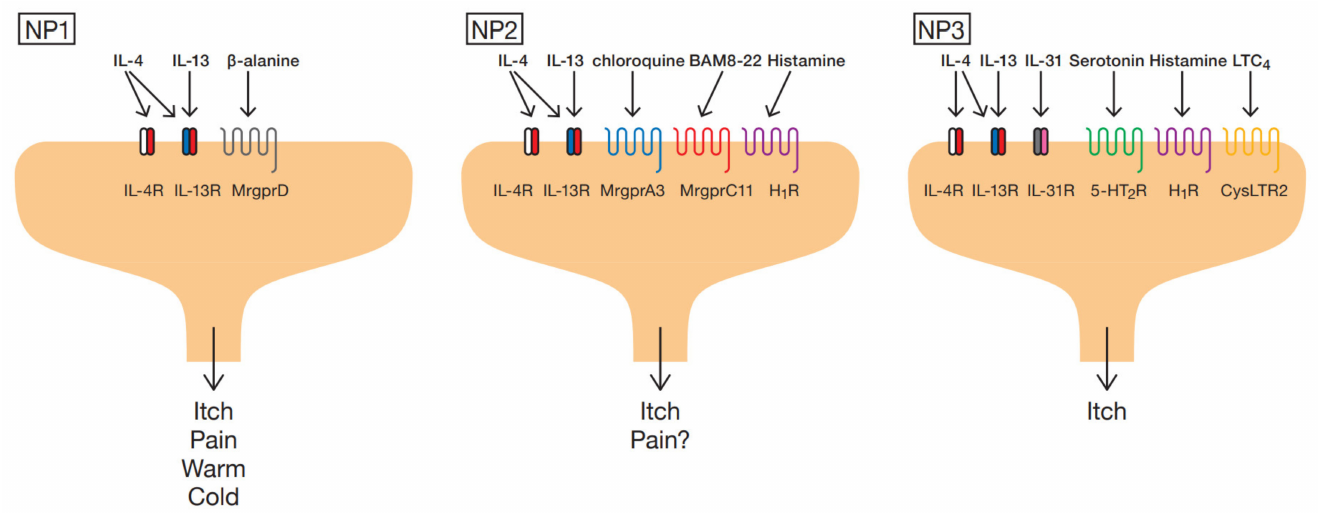
Figure 1. NP clusters of itch-related sensory nerves and itch-related receptors expressed on them. NP1 neurons are positive for IL-4R α , IL-13 R α and MrgprD ( left ). NP2 neurons are positive for IL-4R α , IL-13 R α , MrgprA3, MrgprC11 and H 1 R ( middle ). NP3 neurons are positive for IL-4R α , IL-13 R α , IL-31R, 5-HT2R, H 1 R and CysLTR2 ( right